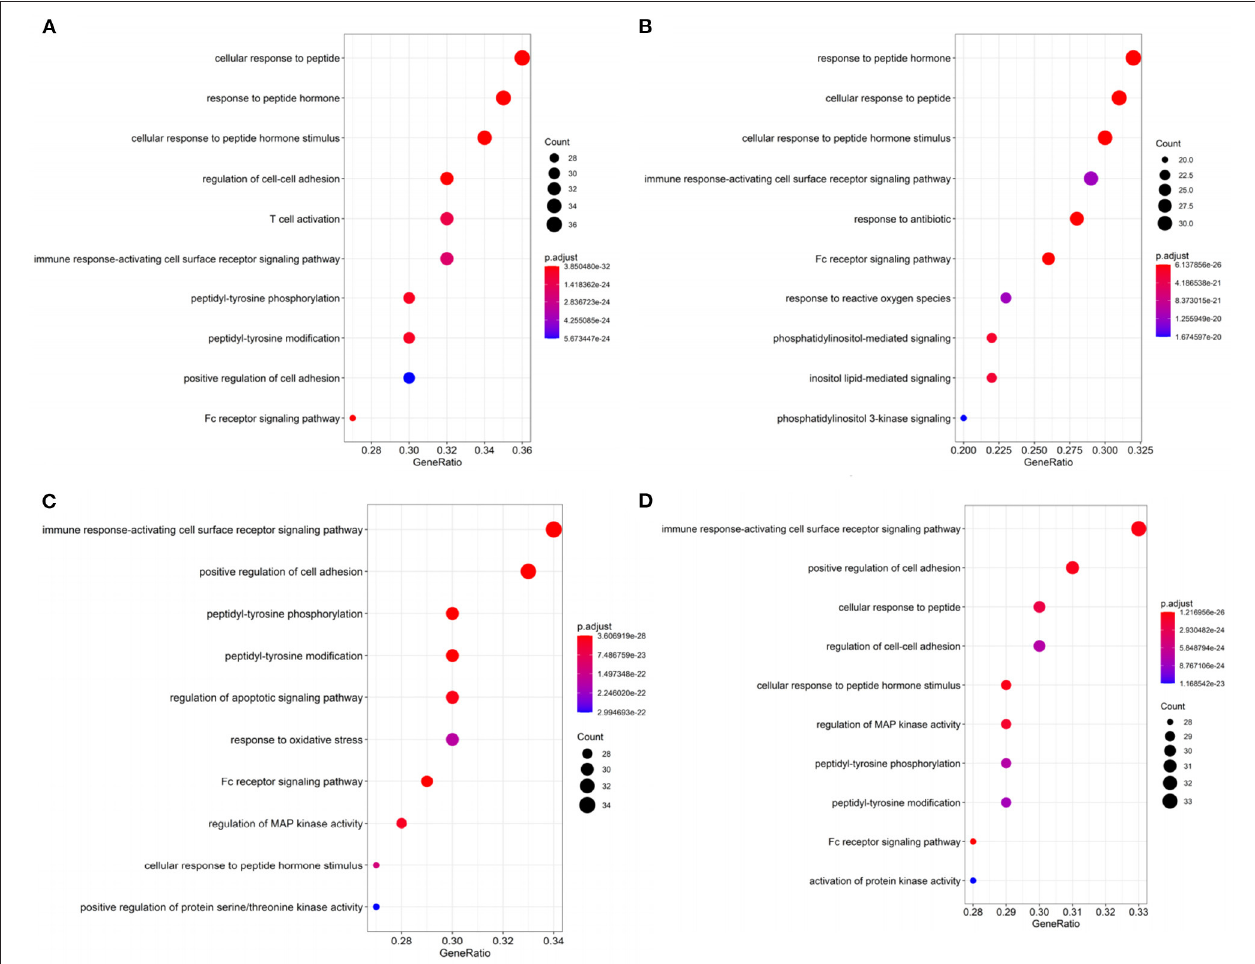
FIGURE 4 | The top 10 gene ontology (GO) terms enrichment of (A) BRCA, (B) HNSC, (C) KIRC, and (D) THCA by significant genes with p < 0.05 in